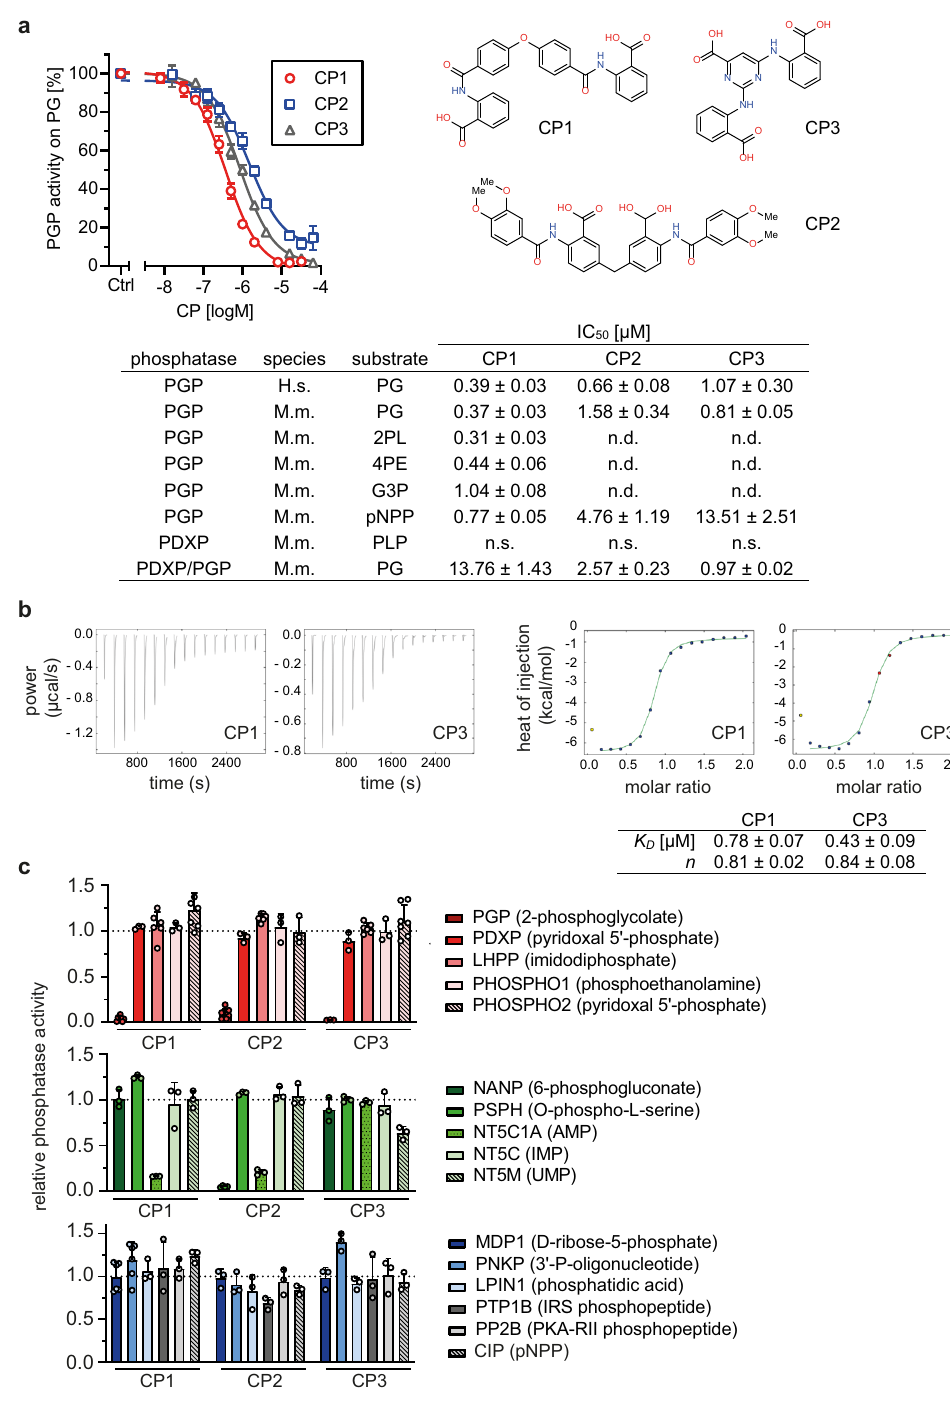
Fig. 1 | Identi fi cation and characterization of phosphoglycolate phosphatase (PGP) inhibitors. a Determination of half-maximal inhibitory constants (IC 50 ) of compounds 1 - 3 (CP1-3, see 2D-structures on the right), using puri fi ed murine PGP and phosphoglycolate (PG) as a substrate. Error bars not shown are hidden by the symbols. The table gives IC 50 values(in µ M) of CP1-3 forpuri fi ed PGP, PDXP, or the PDXP/PGP hybrid protein composed of the PDXP catalytic core and the PGP cap domain. H.s., Homo sapiens; M.m., Mus musculus, n.d., not determined, n.s., no signi fi cant inhibition detectable. All data are mean values± S.E.M of at least n =3 biologically independent experiments. Inhibition of human PGP-catalyzed PG dephosphorylation by CP2 or CP3 was assessed in n =5 or n =4 independent experiments, respectively. Inhibition of murine PGP-catalyzed PG depho- sphorylationbyCP2andCP3,andofmurinePGP-catalyzedG3Pdephosphorylation by CP1 was determined in n =4 independent experiments. b Isothermal titration